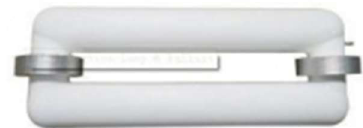
Figure 4. EFL lamp type GS-150W manufactured by Inducled.